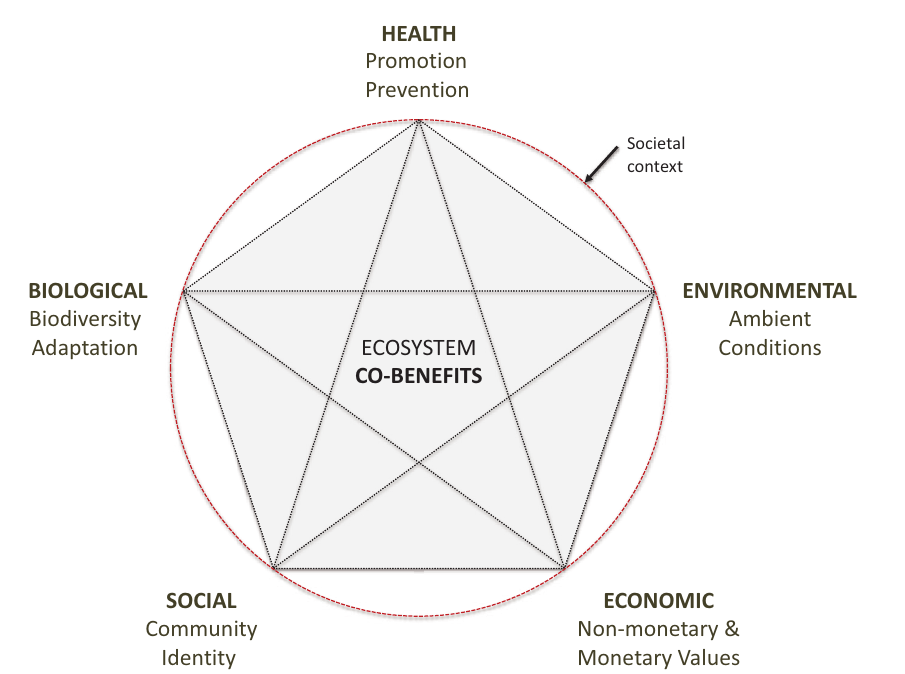
Figure 4. Co‐benefits of public green space are much larger than health and support the provision of green space in cities. Notes: (a) Biological—biodiversity supports adaptability and resilience; (b) economic—increased market values for private properties; (c) environmental—trees absorb carbonic gases, filter fine particulates, and influence ambient temperatures; (d) health—contact time of more than four hours per week is beneficial for children and pregnant women; (d) social—low cost of recreation/physical activity in public green